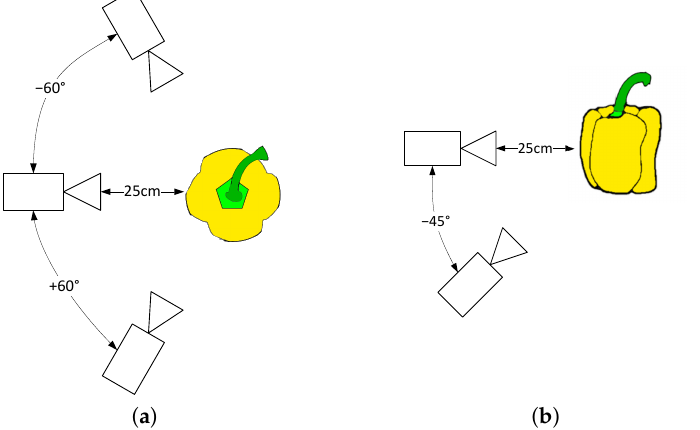
Figure 4. The six viewpoints are combinations of 3 different azimuth ( a ) and 2 different tilt ( b ) angles. Adapted from Harel et al.